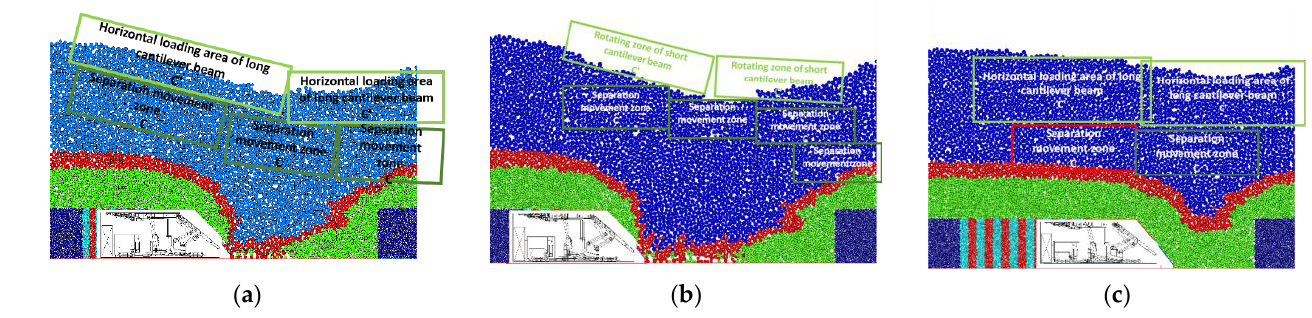
Figure 8. Evolutionary law of top-coal migration and release under different roof boundary conditions. ( a ) Law of top-coal release and migration of step vertical action. ( b ) Law of top-coal release and migration of short cantilever beam — rotary action type. ( c ) Law of top-coal release and migration of long cantilever beam — horizontal action type.